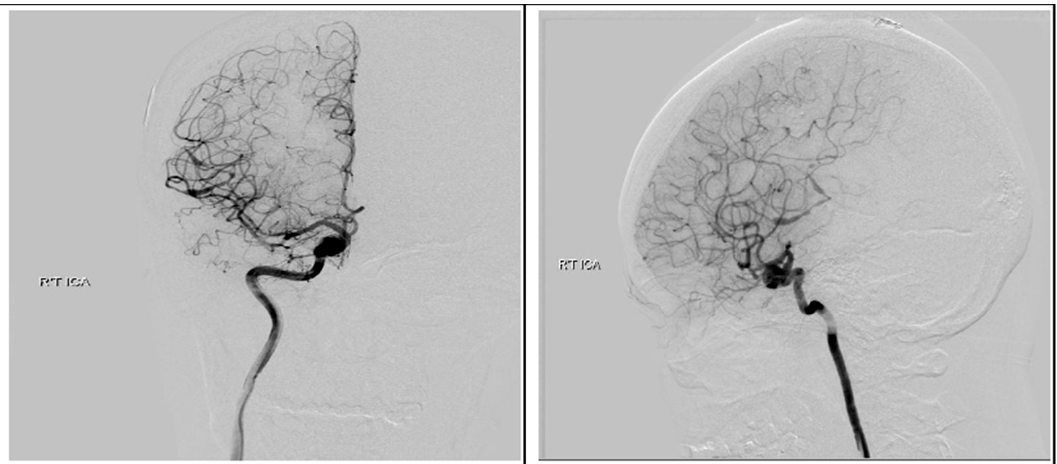
Figure 8. Verhoeff–Van Gieson stain for arteriovenous malformation. Staining showed discontinu- ity of the elastic fibers, which revealed ambiguous vessels exhibiting characteristics of both arteries and veins, consistent with an arteriovenous malformation (red arrow).